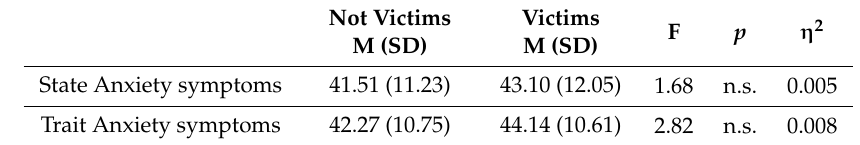
Table 6. State-trait anxiety symptoms: comparison between not victims and victims (one-way